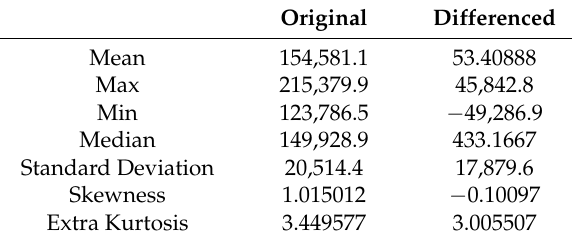
Table 1. Detailed statistics of load time-series.